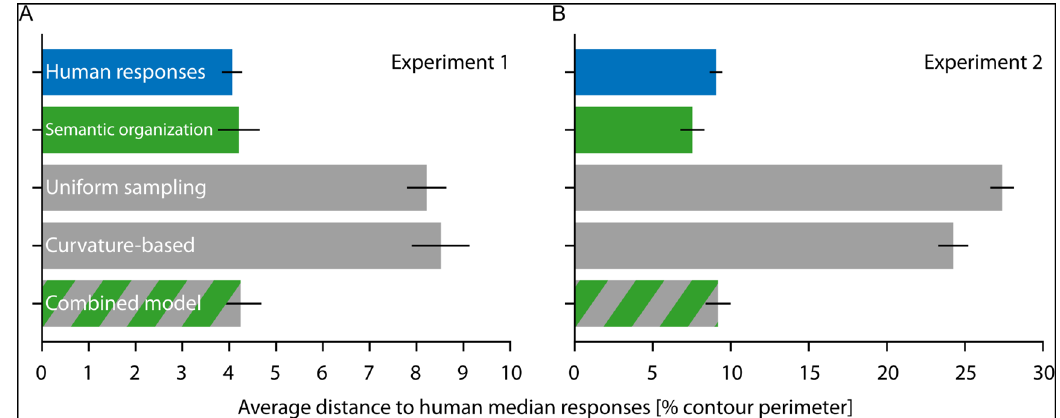
Figure 12. Average distances between human responses and predictions for ( A ) Experiment 1 and ( B ) Experiment 2. We plot the distance between the human response or model predictions and the human median response, expressed as percentage of the perimeter of the contour, and averaged across all stimulus pairs and sample points. The semantic organization model is well within the range of human responses, while the uniform sampling and curvature-based models perform much worse. The combined semantic organization plus curvature-based model does not yield better performance than the semantic organization model